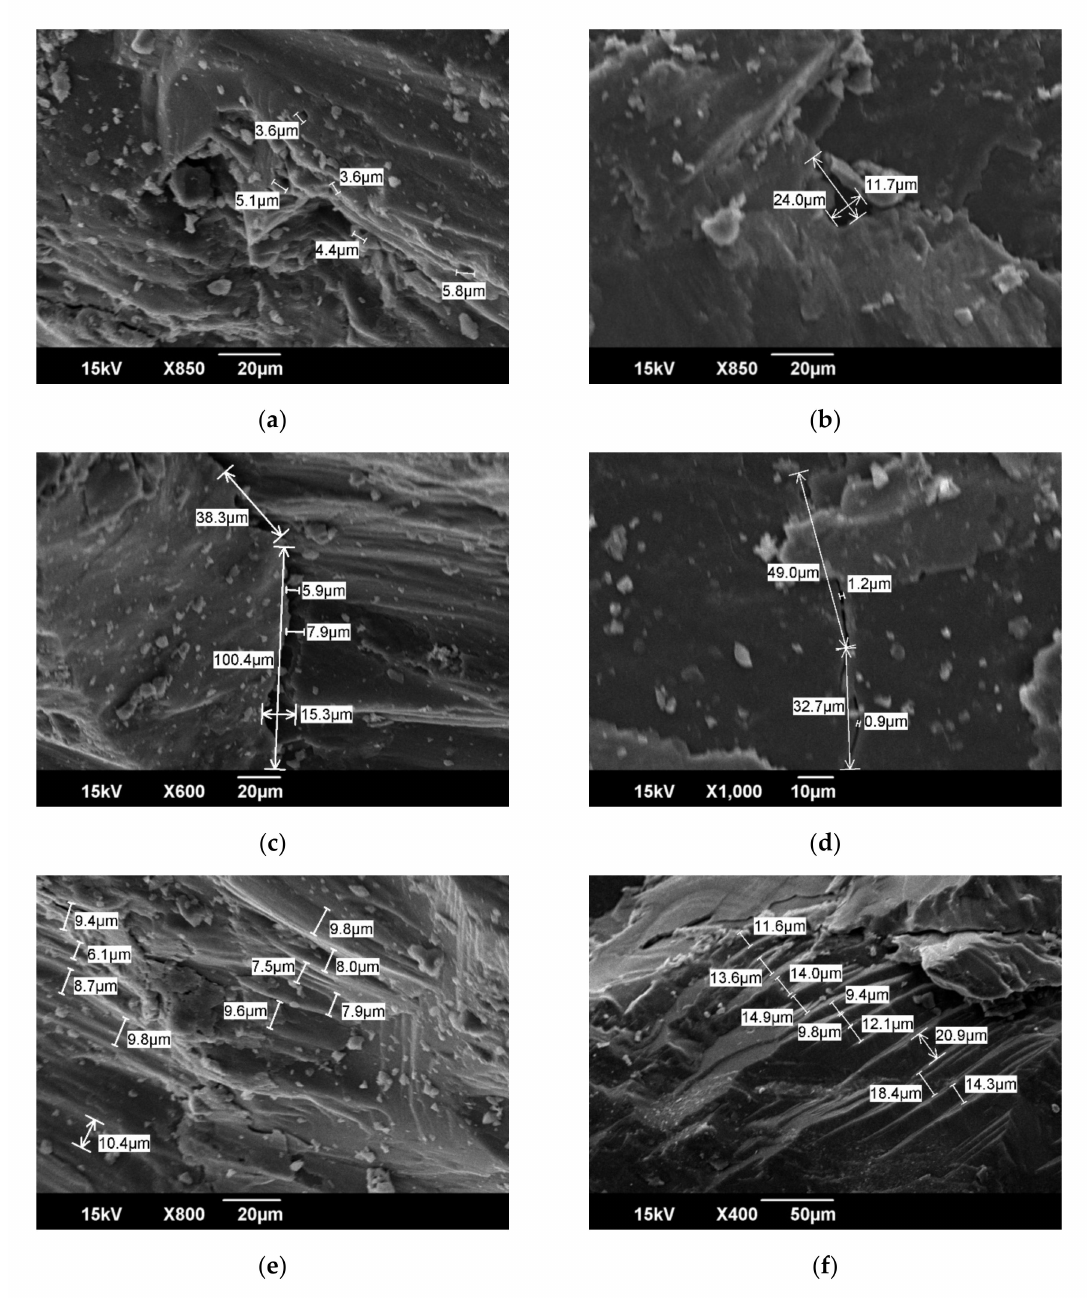
Figure 2. Micron-sized reservoir structure space developed in HNC. In ( a ), the average pore diameter of the thermogenic pores is 4.5 µ m, while in ( b ), a thermogenic pore of 24 µ m × 12 µ m can be observed. In ( c , d ), there are some di ff erences in the observed width development of endogenous fractures, and the former may be due to tensile stress. At × 800 ( e ), the average spacing of organic matter lamellae is ~8.7 µ m; at × 400 ( f ), the average spacing between sections of organic matter is ~13.4 µ